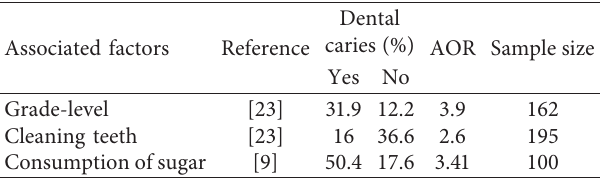
Table 1: Sample size calculation for research on dental caries among primary school children, Ethiopia,